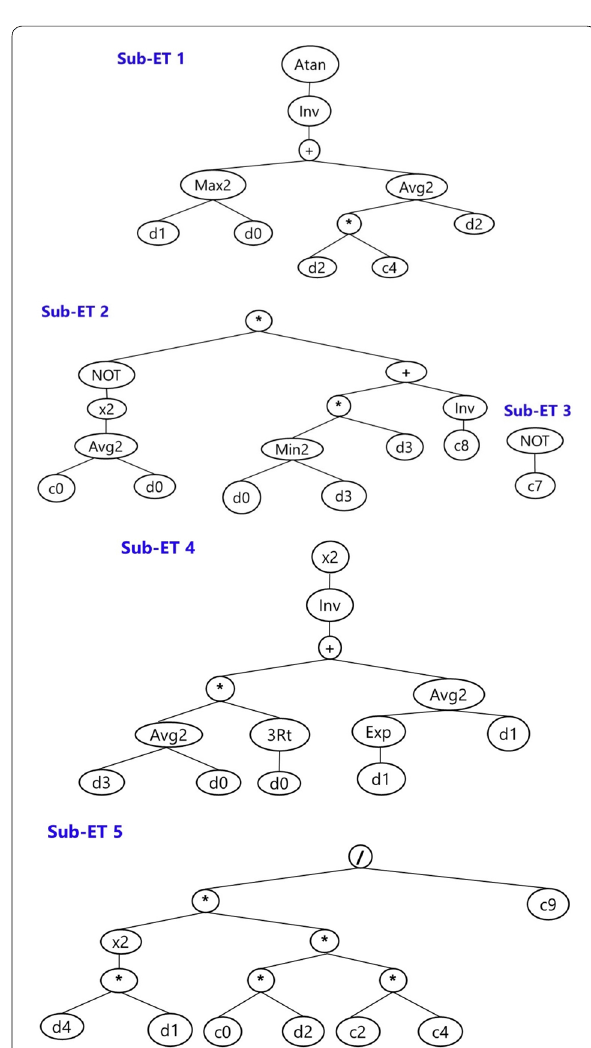
Fig. 3 Expression tree for the MY